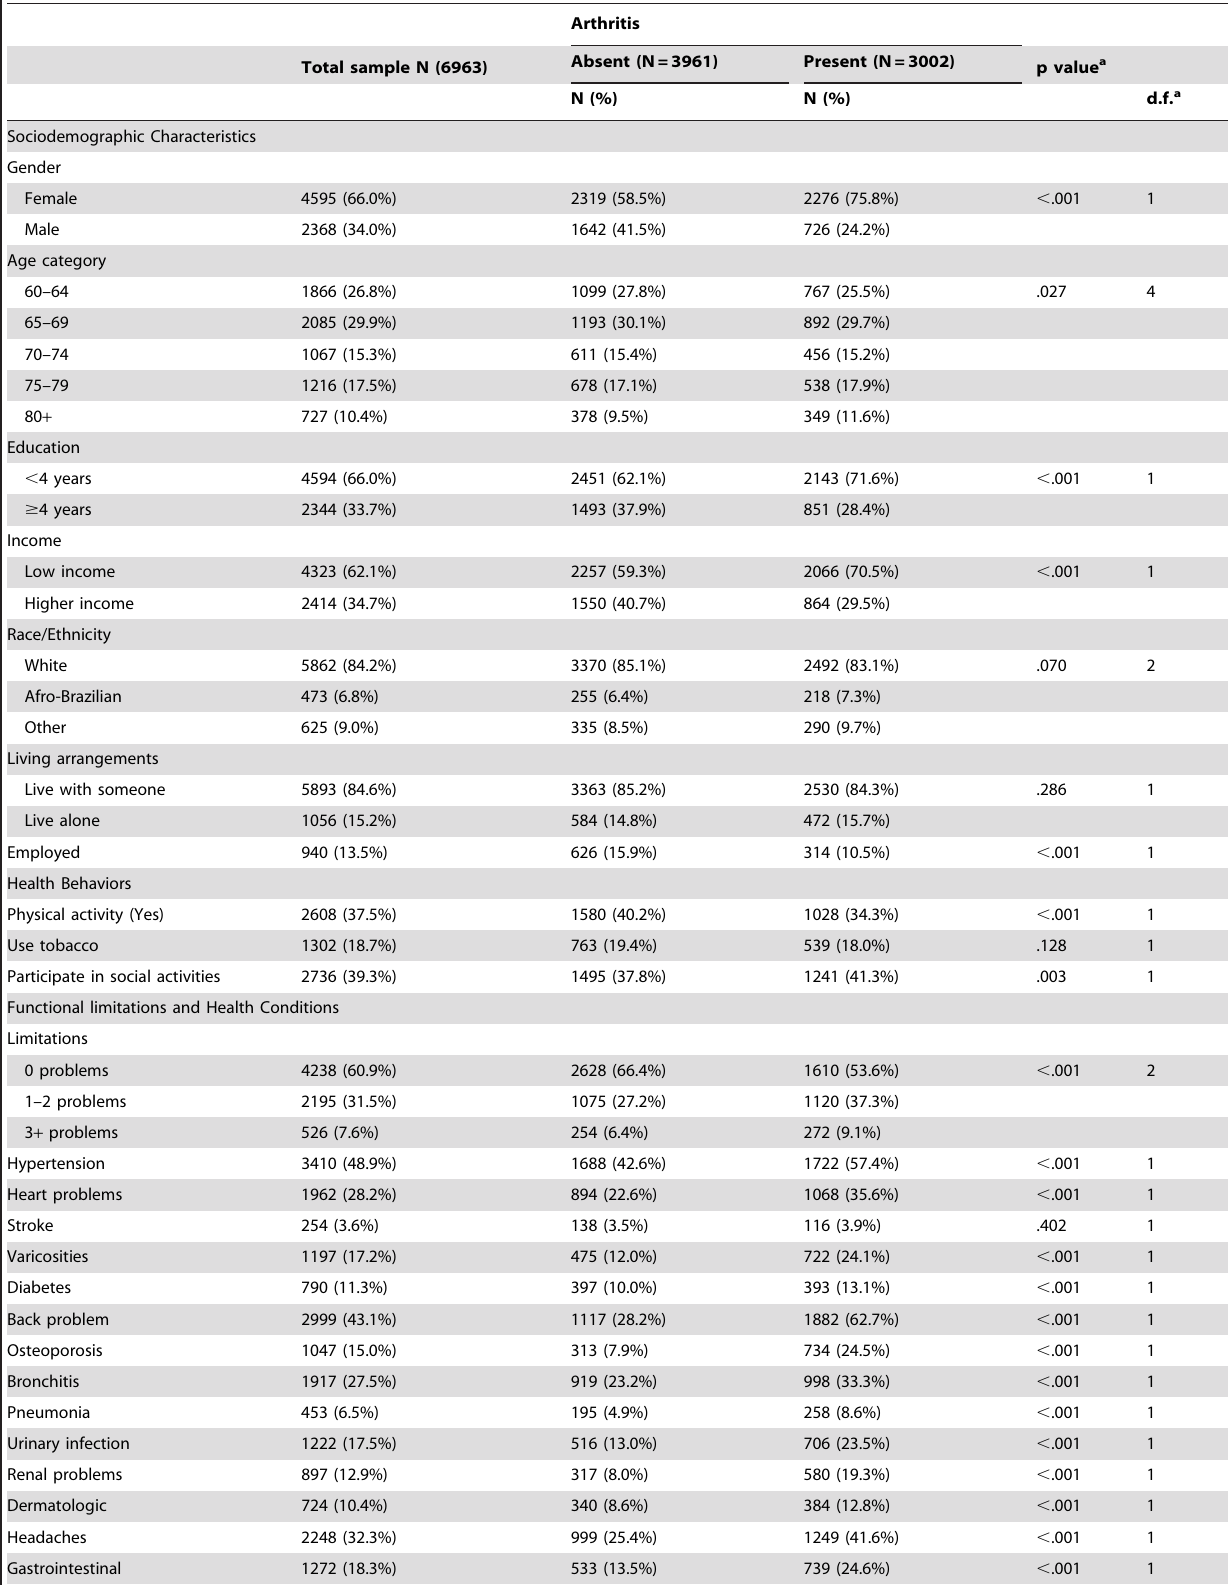
Table 1. Sample characteristics by presence or absence of self-reported